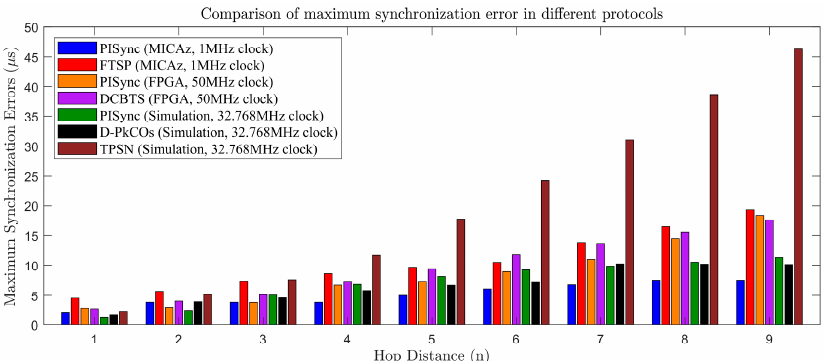
Figure 12. Performance comparison of time synchronization precision of different protocols in a multi-hop sensor network. Different clock configurations are used for a comprehensive comparison, covering both hardware test results and simulation results.